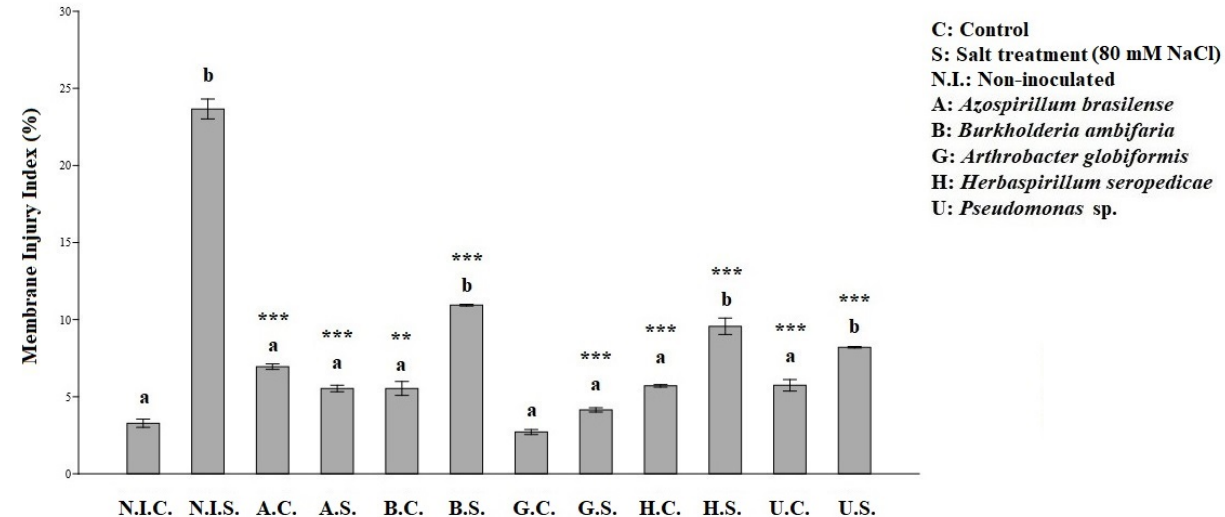
Figure 3. Membrane injury index (M.I.I.) of rapeseed grown in non-saline (C) and in saline soils (S). Data are expressed as means ± SE ( n = 8). N.I. = non inoculated. Mean values in the column marked by different letters are significantly different within the same group ( p ≤ 0.05; ANOVA and Tukey–Kramer test). Significant differences between groups are reported as** p < 0.01; *** p < 0.001.